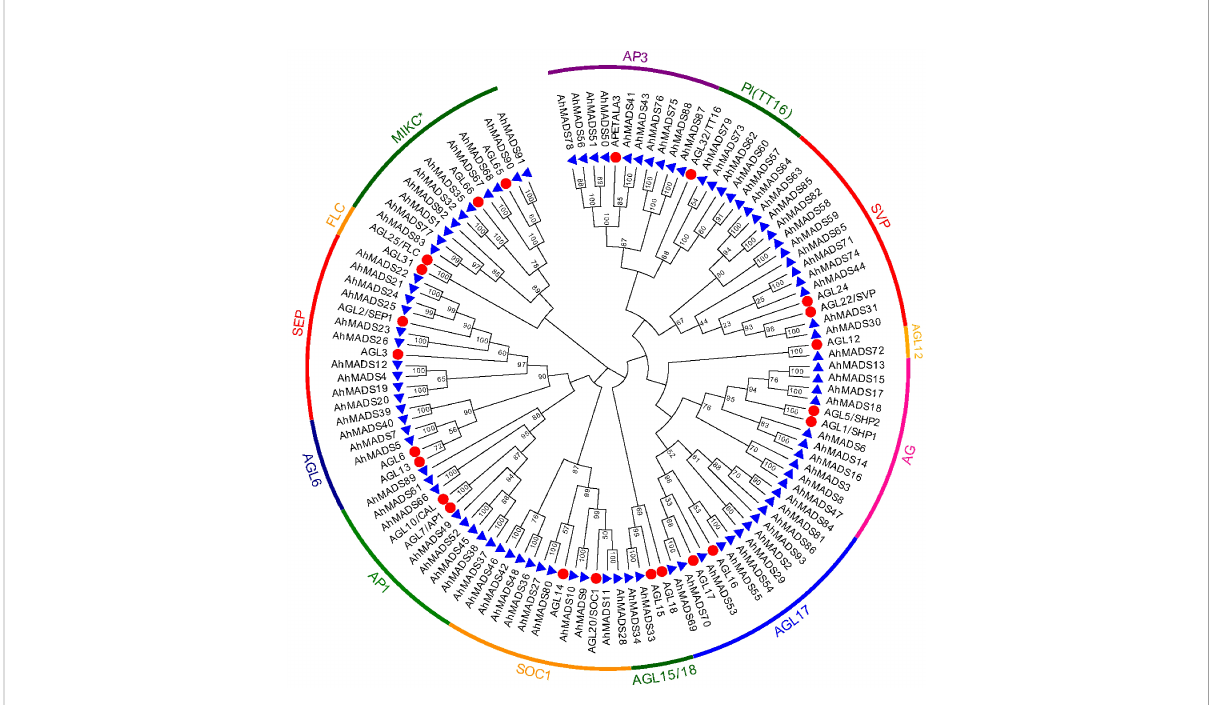
FIGURE 1 Phylogenetic tree of the peanut MIKC-type MADS-box gene family. Phylogenetic tree of 116 MADS-box proteins from peanut (93) and Arabidopsis (23). Twelve subfamilies are highlighted with speci fi c